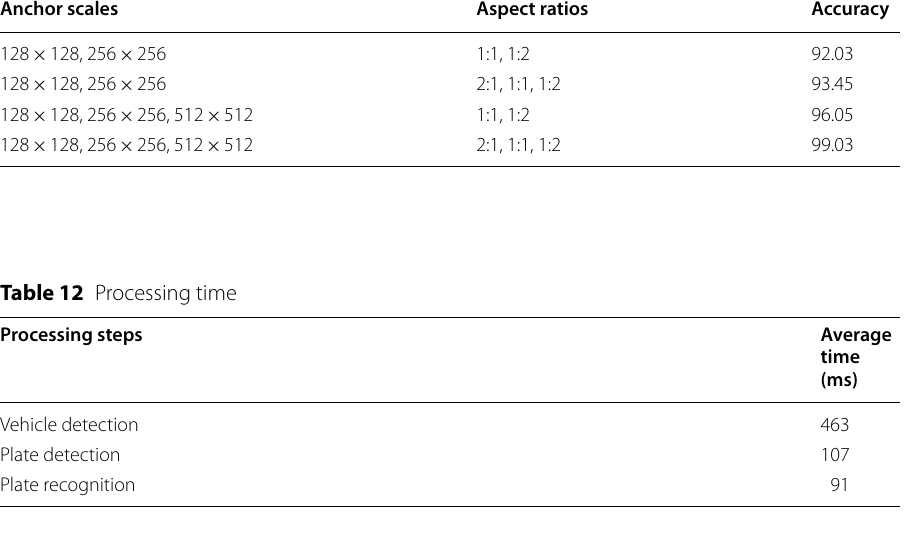
Table 11 Effect of change in scale and aspect ratio on accuracy Anchor scales Aspect ratios